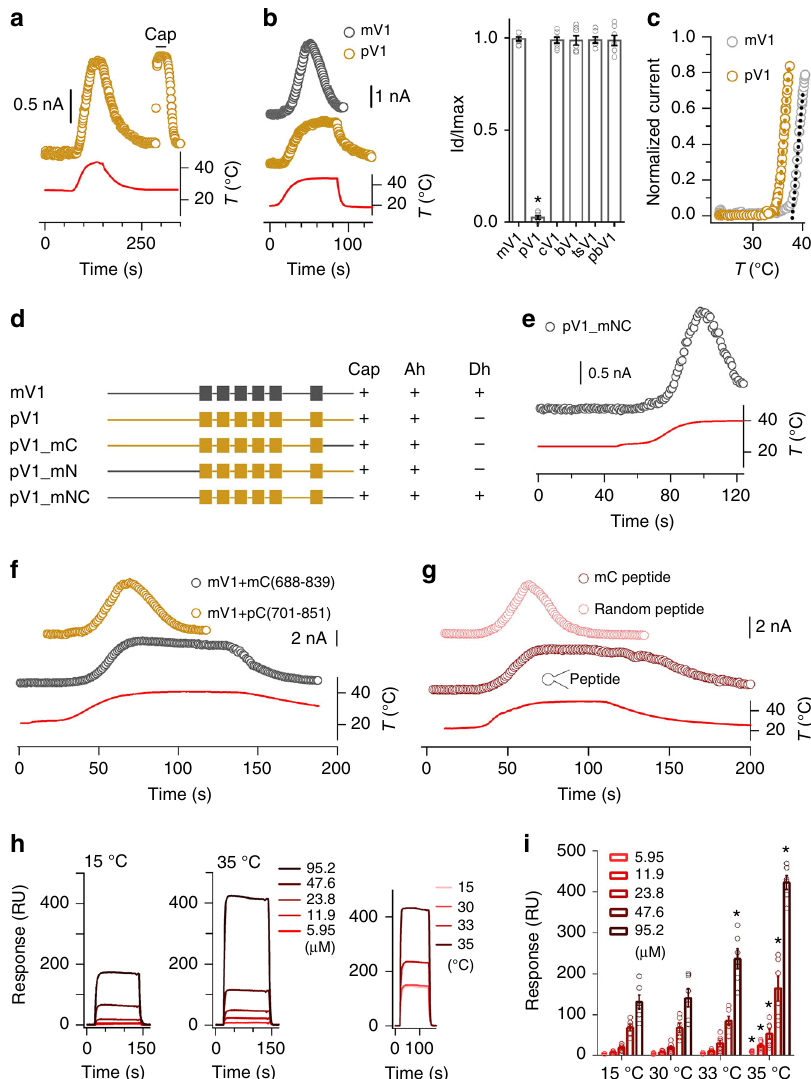
Fig. 1 The Dh transition of TRPV1 is related to N and C termini. a Representative currents of pV1-overexpressing cell activated by heat and 10 μ M capsaicin. b Example current responses of mV1 (gray) and pV1 (yellow) in response to a temperature ramp (left panel). Note that the desensitization of mV1 occurs before cooling starts. Amplitude ratio ( n = 7, two-sided t -test: * p < 0.01) between desensitized currents (Id) and maximum currents (Imax) induced by heat at 45 °C (right panel). c Superimposed representative temperature – response relationships of heat-evoked currents in HEK293T cells transiently transfected with pV1 and mV1. d Chimeric channels were generated between mV1 (gray) and pV1 (yellow) on the basis of the location of